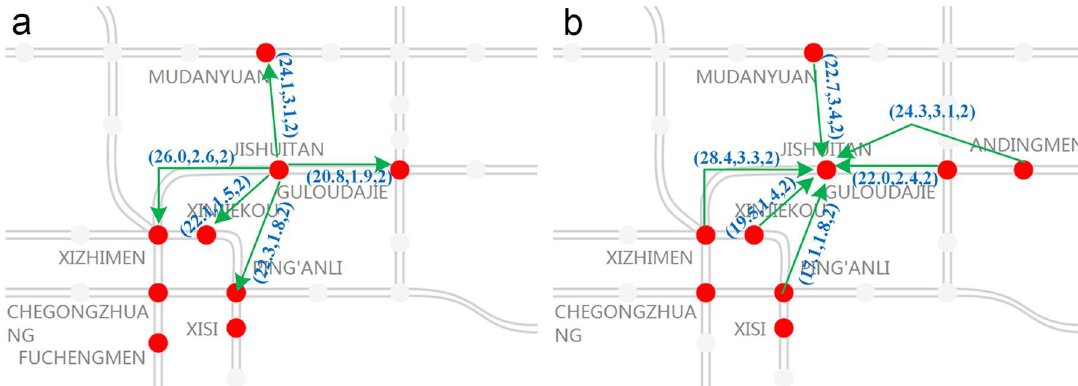
Fig 9. The total time consumption, distance and fee between JISHUITAN station and nearby stations. The parameters ( t , d , f ) on each arc that are marked by a red arrow are the total journey time (minutes), distance(kilometers) and fee (RMB) by bus, includingthe walkingduringthe trip. (a) denotesthe travel cost from the closed station to some nearbystations. (b) indicatesthe travel cost from the nearbystations to the closed station. It should be noted that the travel costs on the arcs in the different directions betweenthe pairs of stations are different.